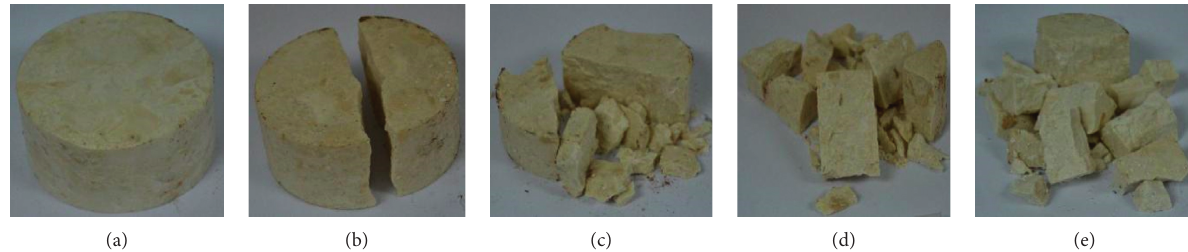
Figure 7: Failure pattern under different strain rates. (a) 55s − 1 , (b) 69s − 1 , (c) 91s − 1 , (d) 100s − 1 , and (e) 111s − 1 .